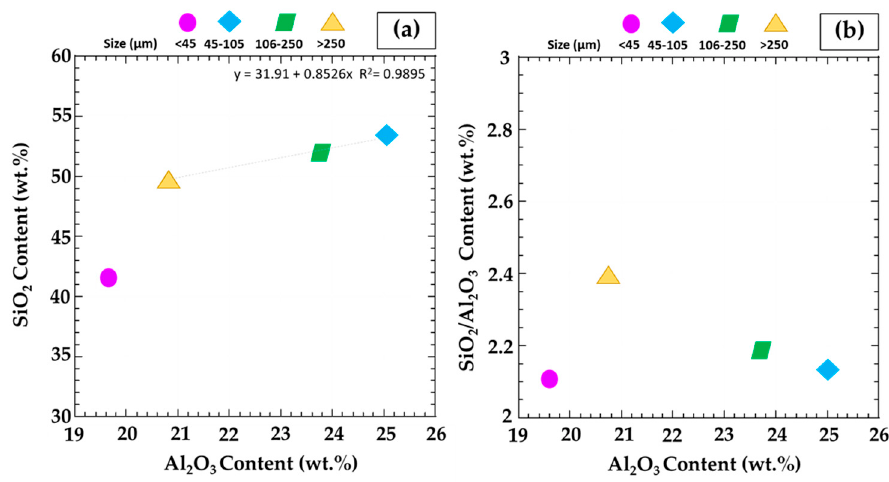
Figure 7. Dependence of ( a ) Al 2 O 3 and SiO 2 contents and ( b ) Al 2 O 3 content and SiO 2 / Al 2 O 3 ratio.